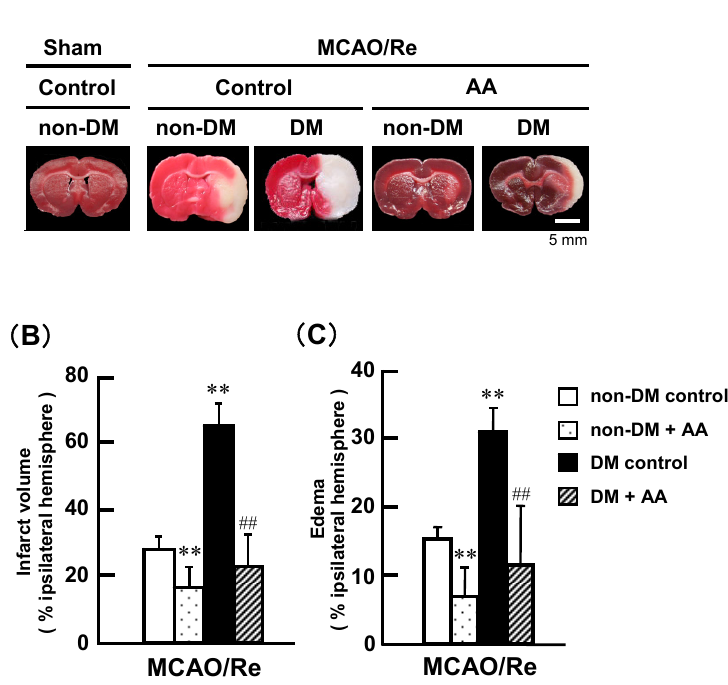
Figure 1. Effects of AA supplementation on infarction induced by MCAO/Re in the brain of nondiabetic and diabetic rats. ( A ) Representative photographs of staining of coronal brain sections from the rats of the nondiabetic + sham operation group and from distilled water-administered (Control) or AA (100 mg/kg)-supplemented nondiabetic or diabetic groups with MCAO with reperfusion (MCAO/Re). AA or water was orally administered once daily for 2 weeks; ( B ) Infarct volume in ischemic hemispheres of the diabetic and nondiabetic groups after MCAO/Re by TTC staining; ( C ) Edema volume in ischemic hemispheres of the diabetic and nondiabetic groups after MCAO/Re. Data are presented as means ± SD ( n = 6–7). ** p < 0.01 compared with the nondiabetic control group. ## p < 0.01 compared with the diabetic control group. DM in the figure denotes diabetic, while non-DM denotes